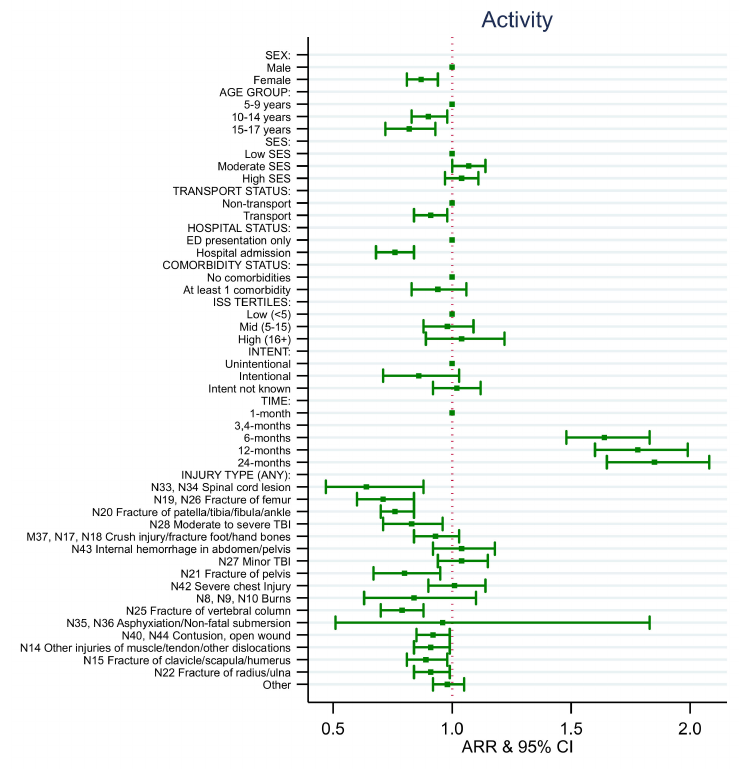
Figure 6. EQ-5D activity adjusted relative risk